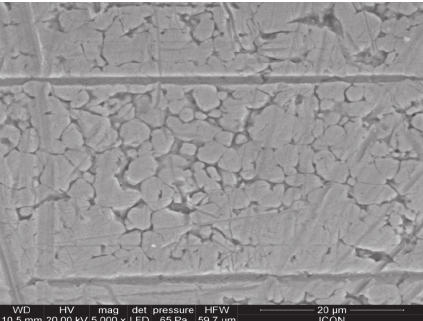
Figure 1: SEM image of Inconel 718 before machining.